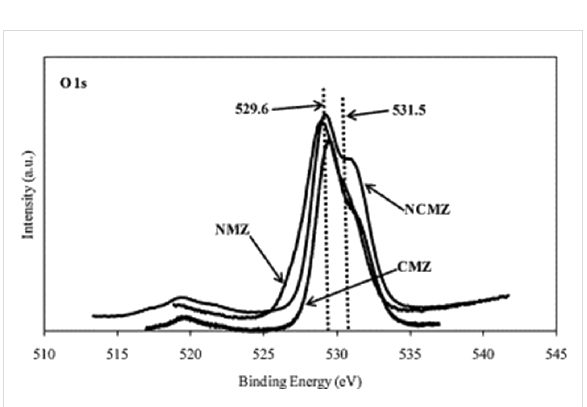
Figure 5: XPS spectra of O 1s of the catalysts. (NCMZ = Ni–Co/ MgO–ZrO 2 , NMZ = Ni/MgO–ZrO 2 , CMZ = Co/MgO–ZrO 2 ). Reprinted with permission from [52], copyright 2010